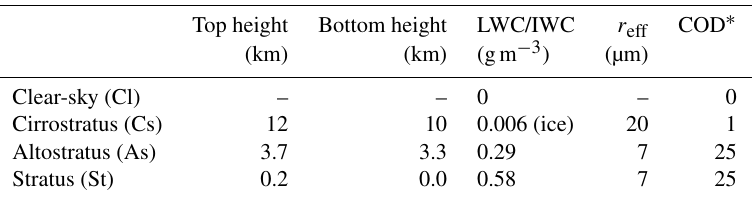
Table 2. Parameters of modelled cloud cases: cloud top and bottom heights, liquid water content (LWC) or ice water content (IWC), effective radii ( r eff ), and cloud optical depth